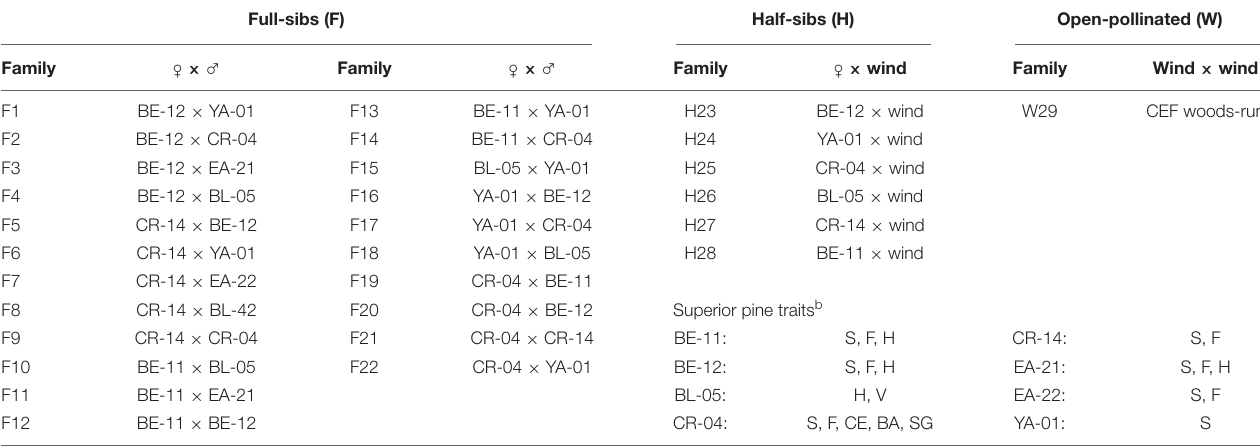
TABLE 1 | Family labels by Georgia-Pacific district codes a and superior pine tree number for the families tested in the 1969 outplanting, Compartment 3, Crossett Experimental Forest. Full-sibs (F) Half-sibs